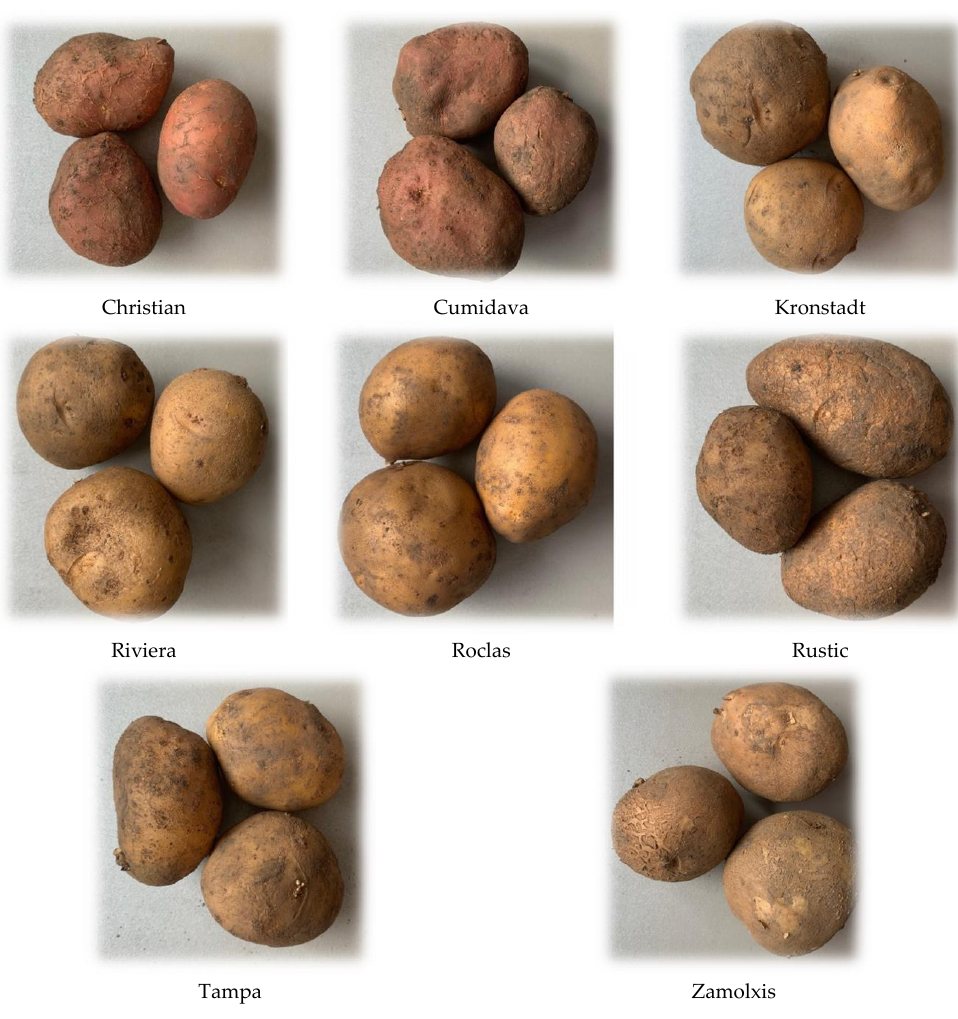
Figure 5. Potato cultivars used in this study 4.2. Chemicals and standards.